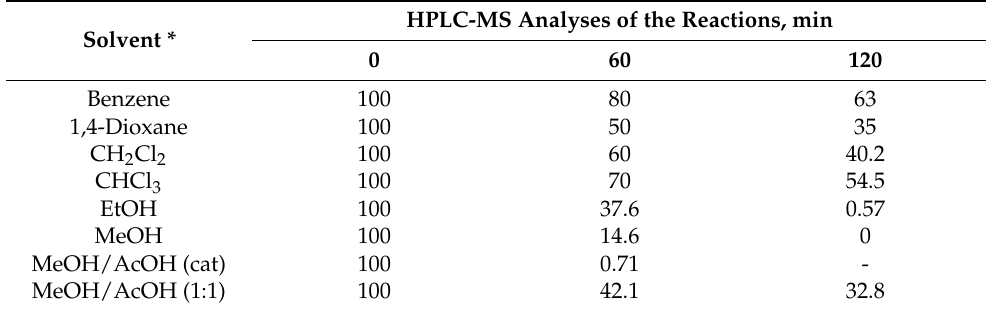
Table 1. Content of 1,2-diamino-4-phenylimidazole determined by the reaction mass (%). Solvent *